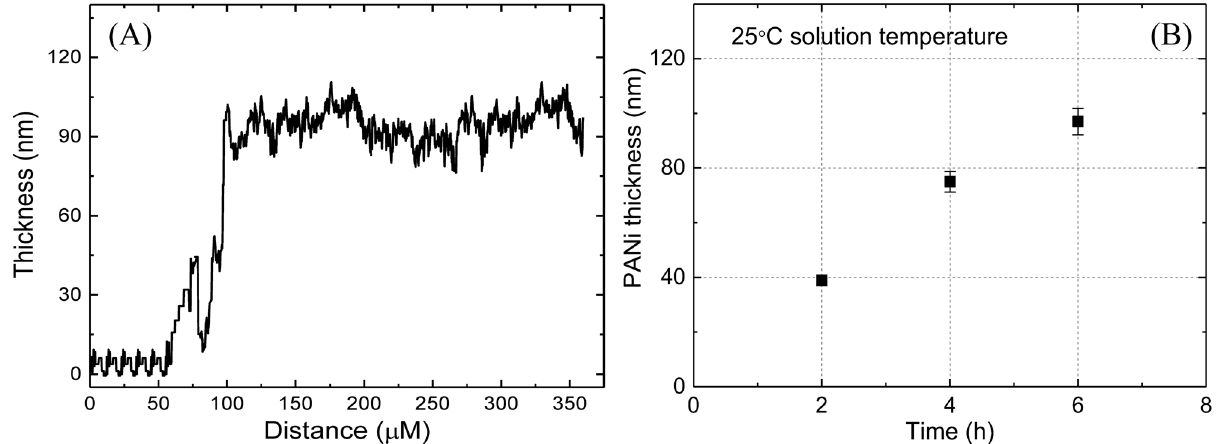
Figure 3. PANI thickness obtained for different reaction times. ( A ) Typical profilometric measurement taken on a PANI/Pt-coated FO-SPR sensor kept for 6 h in the reactive medium, showing a PANI thickness of ~ 95 nm. ( B ) Thickness of electrolessly-deposited PANI films obtained in the equimolar (0.4 M) solution of aniline and H 2 SO 4 at 25 °C, after 2, 4 and 6 h, respectively. The error bars represent standard deviation (n = 3). Processed using Origin 9.6.0.172 (OriginLab 2019), https:// www. origi nlab.